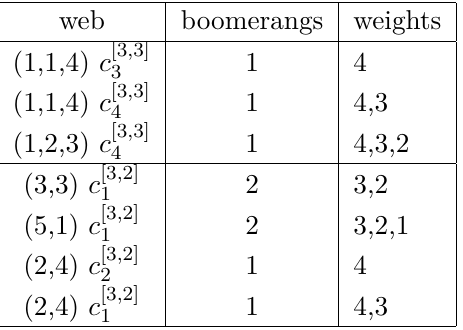
Table 2 . Transcendental weights in the kinematic functions of three-loop webs. The left column specifies the web and the colour factor component using the bases in eqs. (5.1) and (5.25), the middle column presents the number of boomerang gluons, and the right one the weights of the transcendental functions entering the anomalous